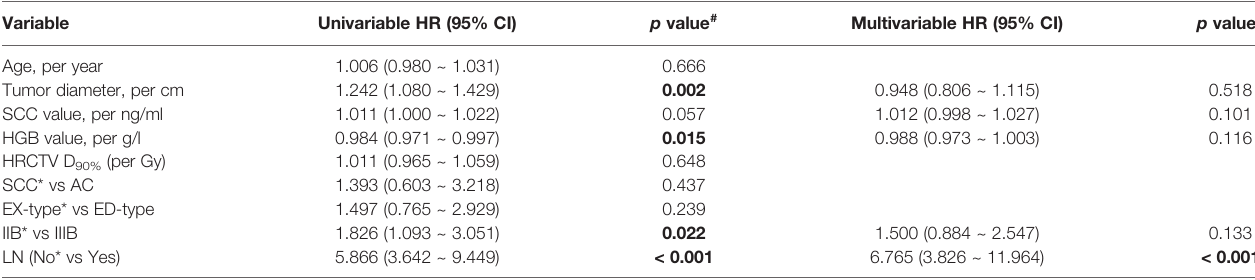
TABLE 4 | Risk factors of OS identi fi ed by univariable and multivariable